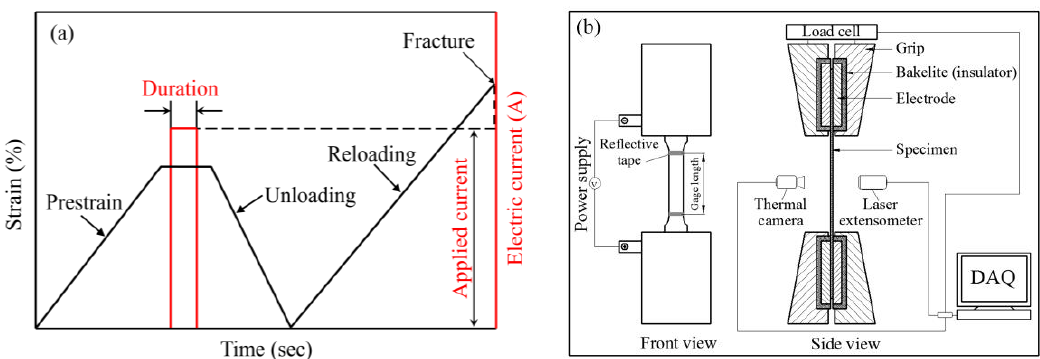
Figure 1. Schematics of ( a ) electrically assisted (EA) annealing with a single pulse of electric current and ( b ) the experimental set-up.